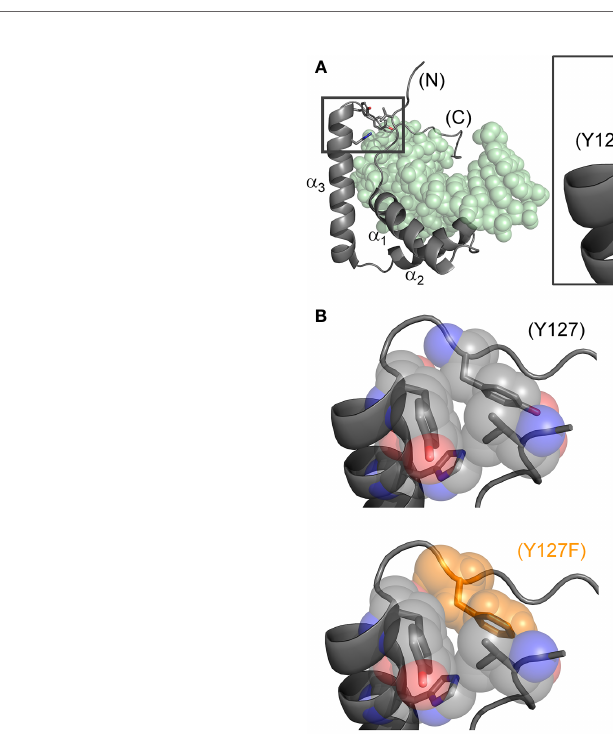
FIGURE 2 | Structural models of wild-type and mutant side chains. (A) L-shaped SRY HMG box ( a -helices labeled a 1-3 ) bound to a DNA target site (light green spheres; PDB entry 1J46) (7). Shown at right is an expanded view of boxed region depicting minor-wing mini-core (full-length numbering scheme). (B) Rigid-body substitution of mutant side chains at box position 72 (sticks) in an otherwise transparent CPK model. Models of the three clinical mutants (34, 44, 45): Y127C in red, Y127F in orange and Y127H in